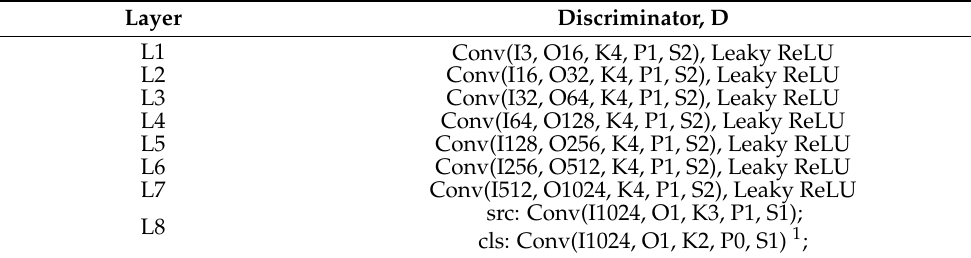
Table 4. Architecture of the